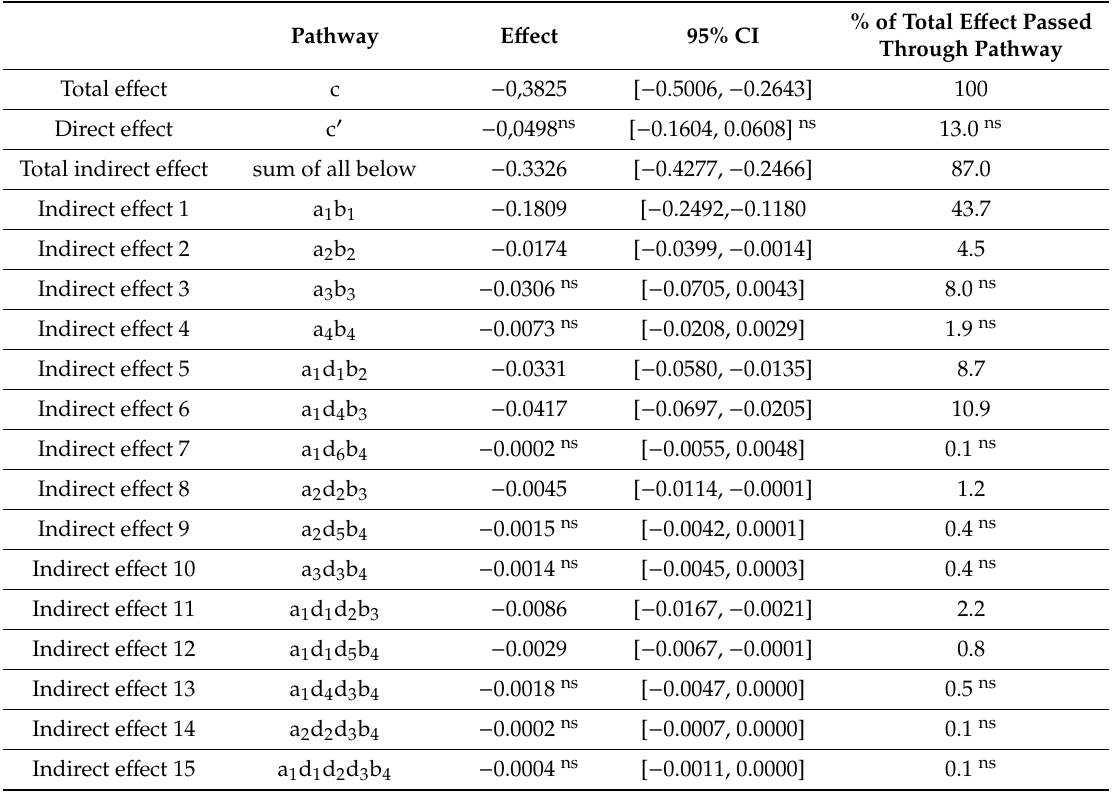
Table A6. Direct and indirect e ff ects for mediating pathways of the relationship between stress in 2012 and work ability in 2017 in males ( n = 575).